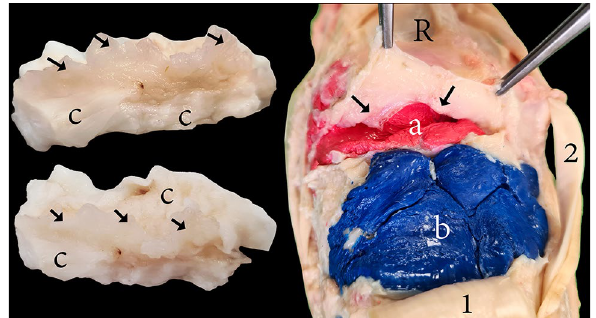
Figure 2. Dorsal view of a left carpal joint showing (a) the casted radiocarpal joint cavity, (b) the casted intercarpal joint cavity, and (c) the internal service of the dorsal joint capsule. R, radius; 1, extensor carpi radialis tendon reflected distally; 2, common digital extensor tendon. The black arrows indicate the folds of the synovial membrane.